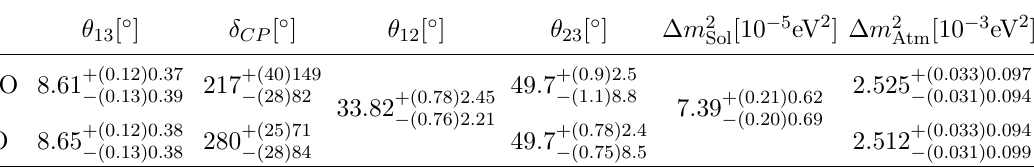
Table 1 . The global fit of three-flavor oscillation parameters at the best-fit and (1 σ )3 σ level with Super-Kamiokande atmospheric data [15]. NO = normal neutrino mass ordering; IO =